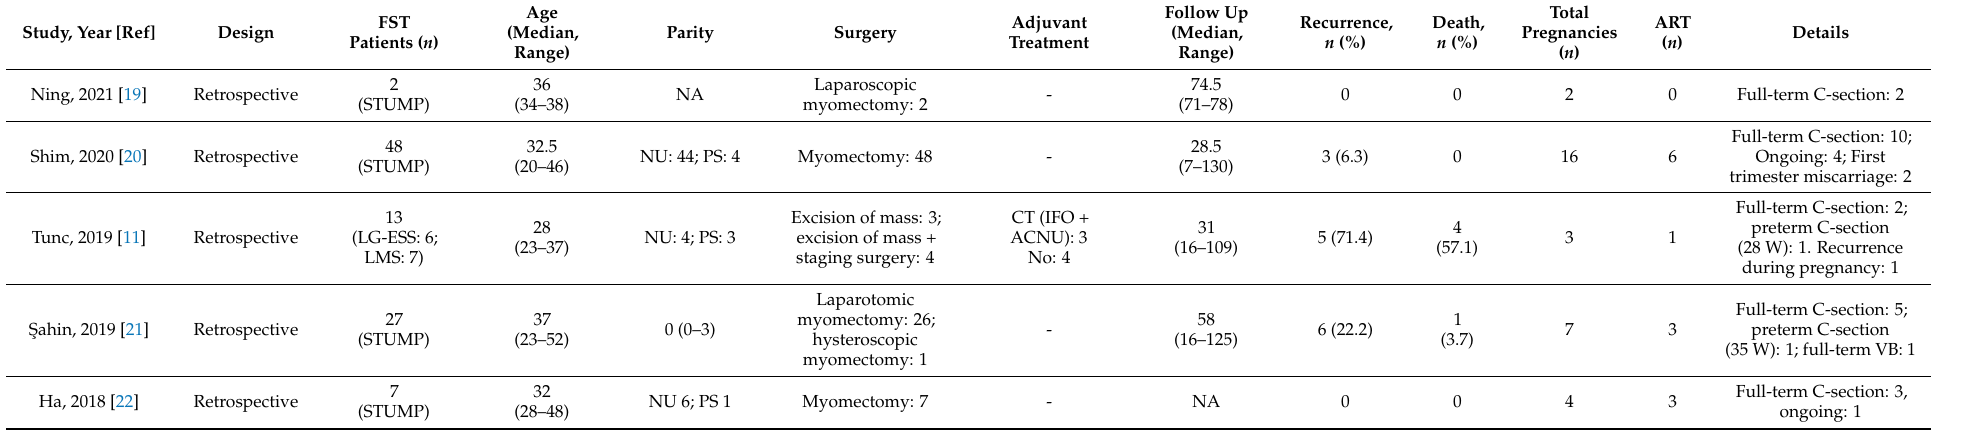
Table 5. Published reproductive and oncologic outcomes after FST of STUMP and LMS.